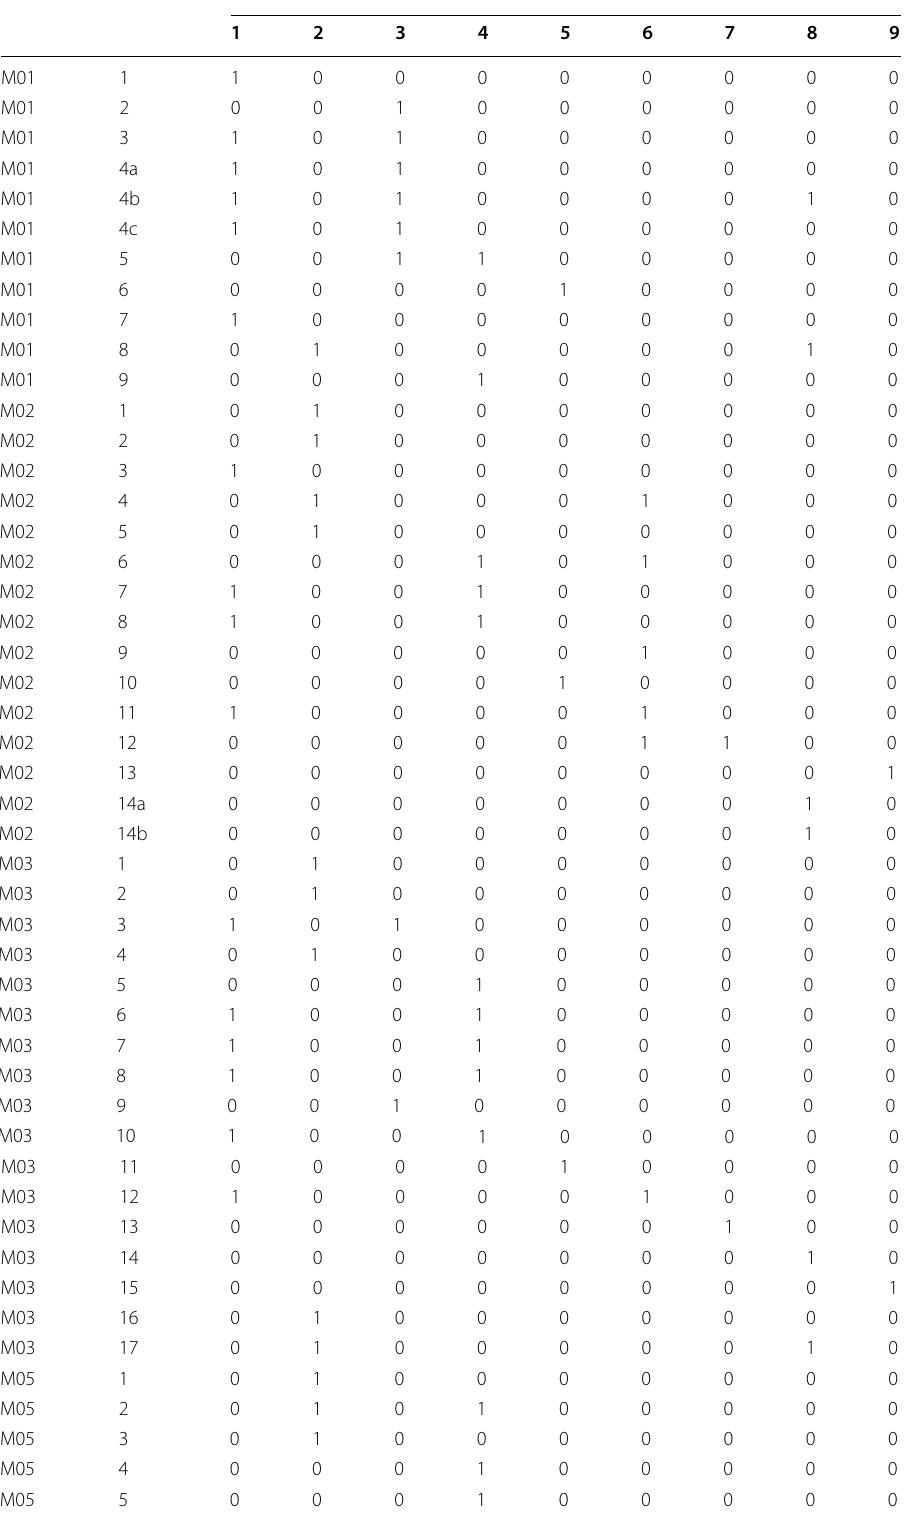
Table 13 Q-matrix refined by the stepwise method: Australia Block